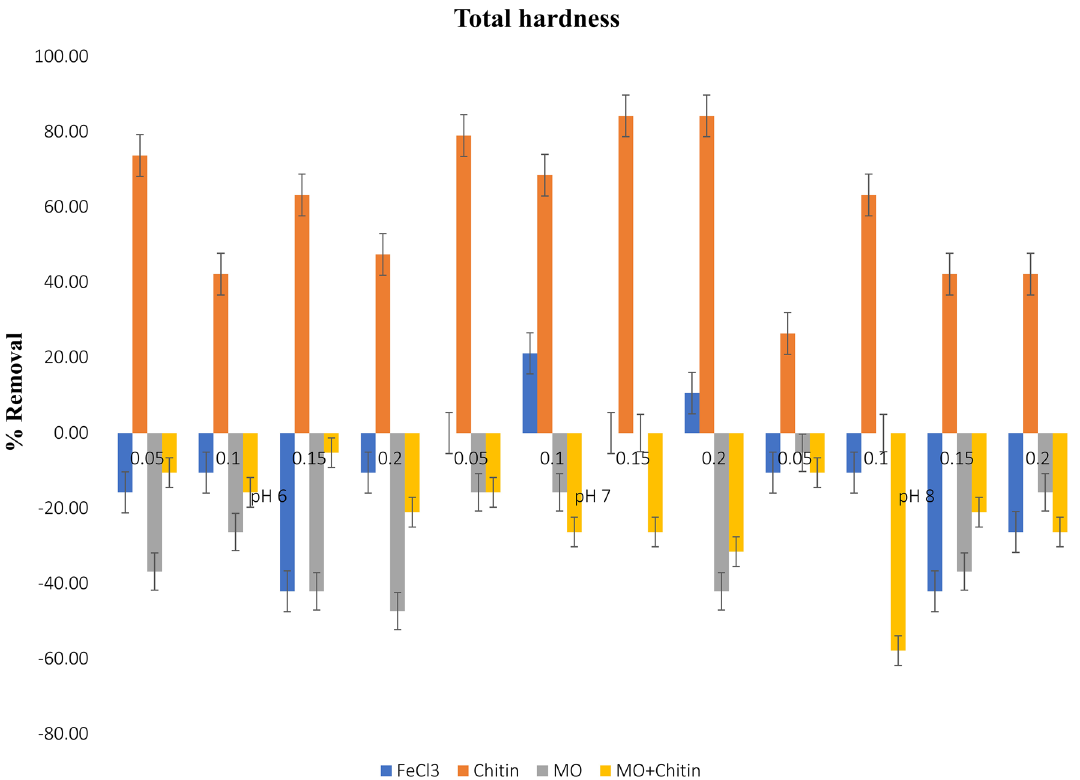
Fig. 5 Total hardness reduction by the